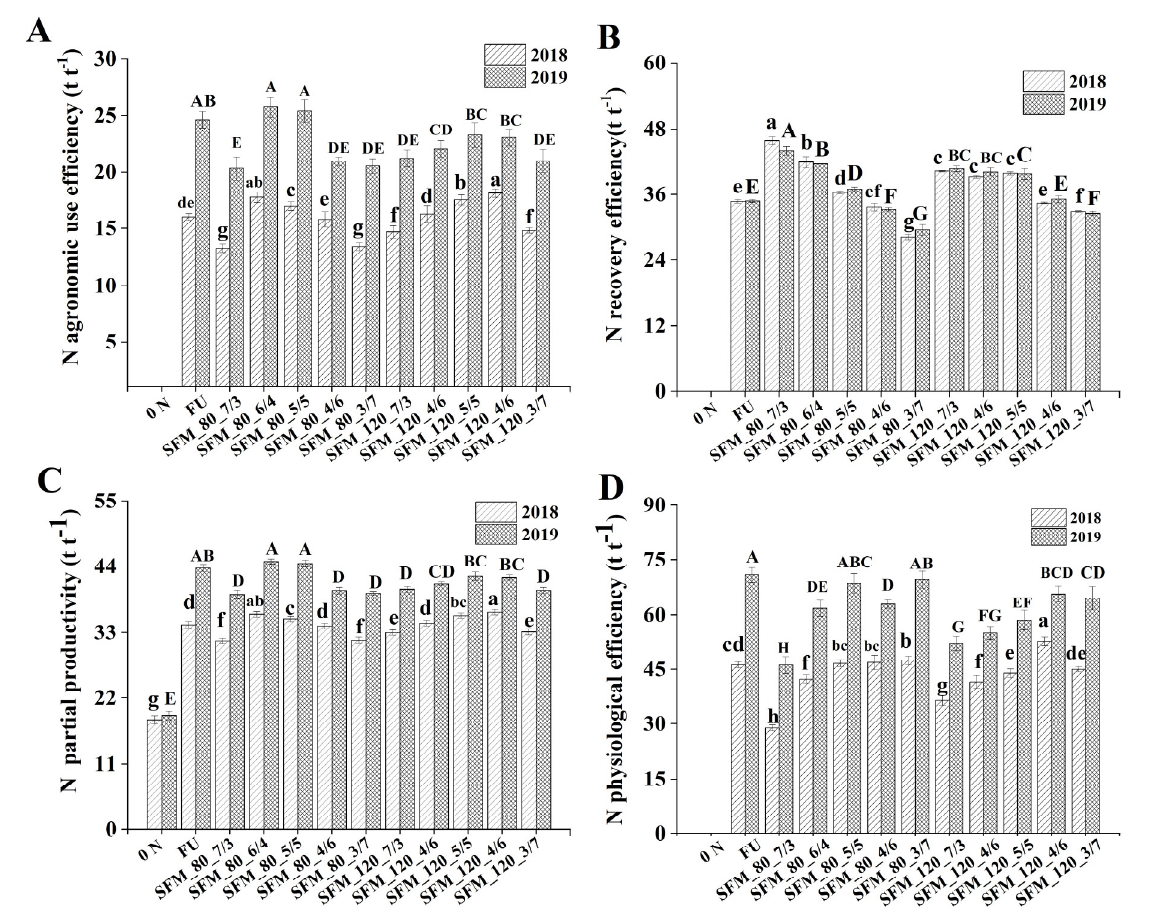
Figure 1. Effects of different fertilization modes on N agronomic use efficiency (NAE) ( A ), N recovery efficiency (NRE) ( B ), N particle productivity (NPP) ( C ), N physiological efficiency (NPE) ( D ) in 2018 and 2019. 0 N, FU, SFM represent no nitrogen application, fractionated urea, simplified